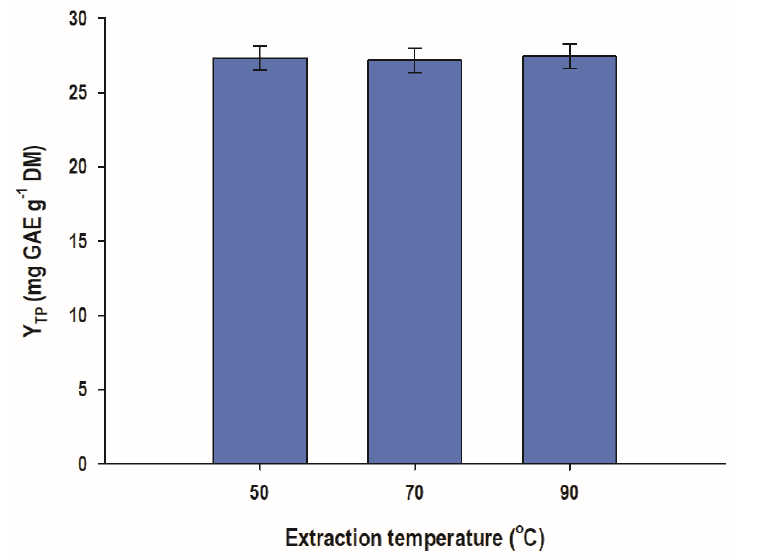
Figure 1. WOP aqueous extraction to test temperature effects on total polyphenol yield. The extractions were carried out with a liquid-to-solid ratio of 20 mL g − 1 , for 1 h, under stirring at 500 rpm.